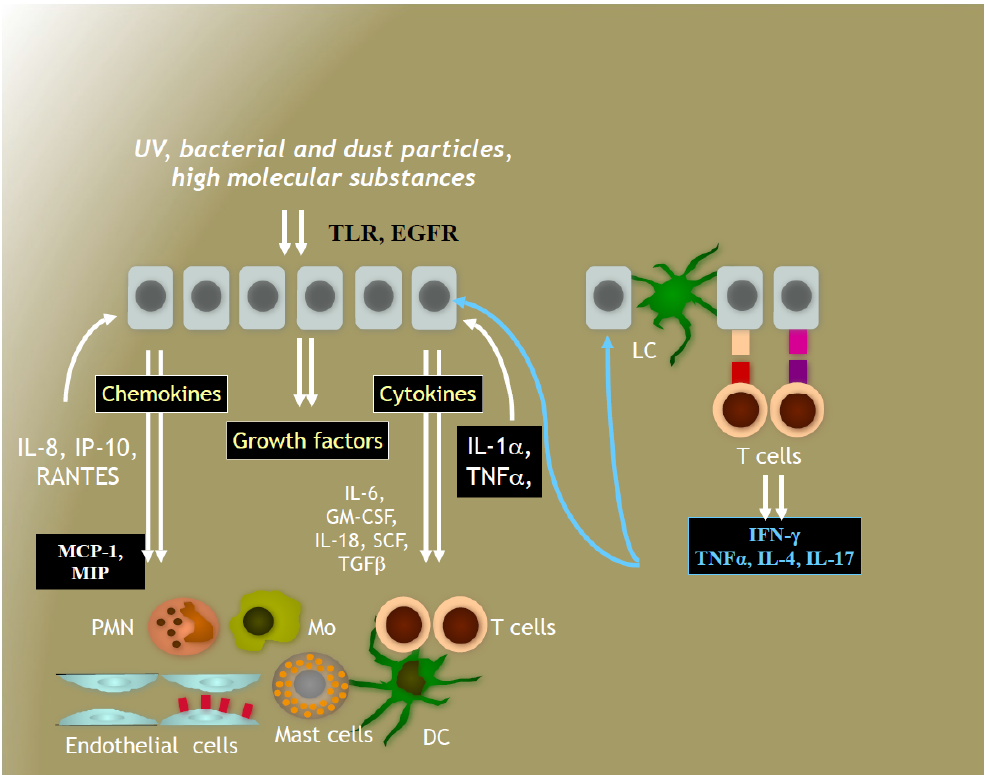
Figure 7. Immune system in human skin. Skin immune system consists of cells-residents (mainly, keratinocytes, tissue macrophages, dendritic and Langerhans cells) and recruited professional immune cells, such as lymphocytes, granulocytes, and monocytes. Immune cells react to foreign invaders and UV radiation by synthesising de novo a plethora of cytokines and chemokines as well as growth factors. UV-responsive cellular receptors, such as Toll-like (TLR), epidermal growth factor receptor (EGFR), aryl hydrocarbon receptor (AhR) initiate molecular events with the aid of specialised nuclear factors (NF-kappaB and Nrf2), which lead to metabolic and inflammatory response of the skin in order to protect intra-cutaneous homeostasis. Photo-protective secondary plant metabolites could modulate these molecular events, thus enhancing the